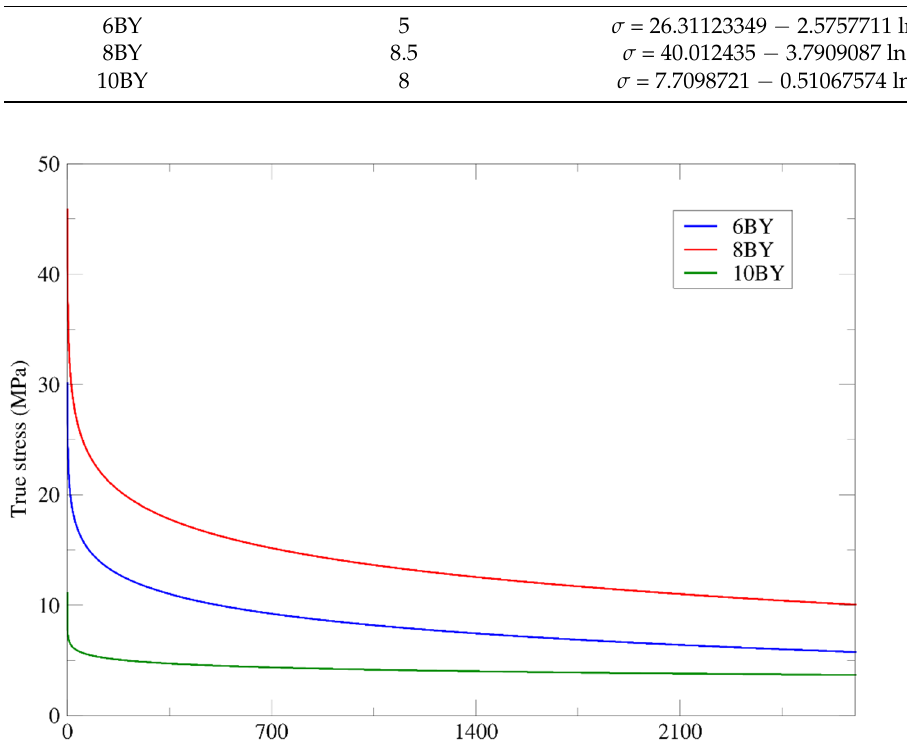
Figure 13. Mean curves of tensile relaxation tests of PVA 6BY, 8BY, and 10BY. Table 4. Mean true stress within 2700 s for PVA braided architectures ( ε 0 = ε (0.16 σ u ).